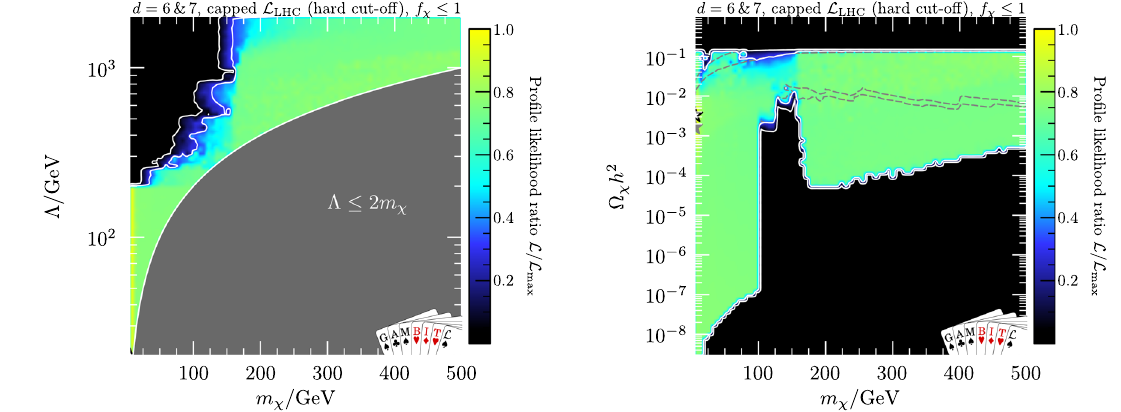
Fig. 7 Profile likelihood in the m χ – (cid:2) plane (left) and in terms of m χ and the predicted relic density (right) when considering all dimension- 6 and dimension-7 operators, and capping the LHC likelihood at the value of the background-only hypothesis. The white contours show the